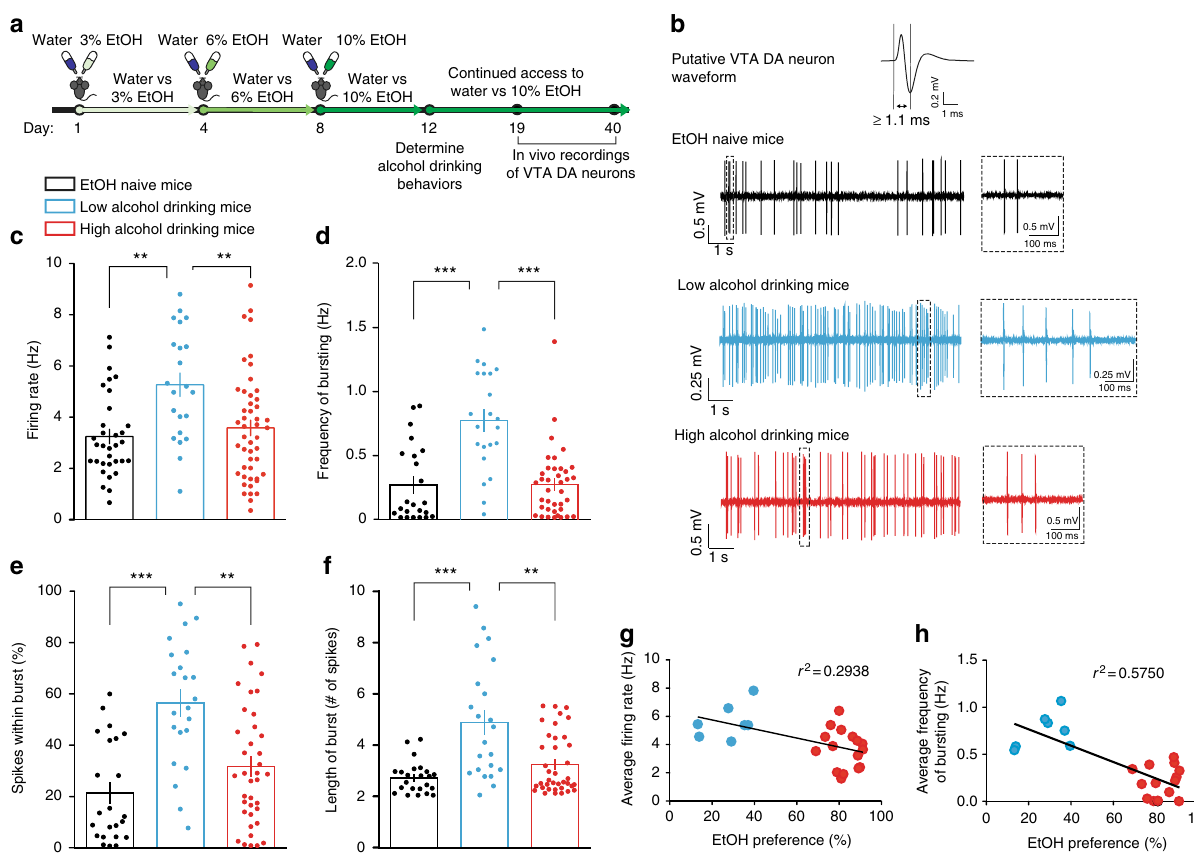
Fig. 2 Low alcohol drinking mice have higher VTA dopamine neuron activity in vivo. a Timeline for experiments and schematic of single-unit recordings. b Representative in vivo VTA dopamine (DA) neuron fi ring traces for EtOH naive, low alcohol drinking, and high alcohol drinking mice, where dashed boxes show representative bursts. c VTA DA neuron fi ring rate in vivo (Kruskal – Wallis: K (3) = 12.74, P < 0.01; post hoc Dunn ’ s multiple comparison test, ** P < 0.01. n = 33 cells from 7 mice; n = 22 cells from 7 mice; n = 48 cells from 16 mice). d VTA DA neuron frequency of in vivo bursting (Kruskal – Wallis: K (3) = 23.88, P < 0.0001; post hoc Dunn ’ s multiple comparison test, *** P < 0.001. n = 23 cells from 7 mice; n = 22 cells from 7 mice; n = 38 cells from 15 mice). e VTA DA neuron percentage of spikes within a burst in vivo (Kruskal – Wallis: K = 21.02, P < 0.0001; post hoc Dunn ’ s multiple (3) comparison test, ** P < 0.01, *** P < 0.001. n = 23 cells from 7 mice; n = 22 cells from 7 mice; n = 38 cells from 15 mice). f Average length of burst in VTA DA neurons in vivo (Kruskal – Wallis: K (3) = 16.34, P < 0.001; post hoc Dunn ’ s multiple comparison test, *** P < 0.001, ** P < 0.01. n = 23 cells from 7 mice; n = 22 cells from 7 mice; n = 38 cells from 15 mice). g Correlation between average VTA DA neuron in vivo fi ring rate and EtOH preference from individual alcohol drinking mice ( r 2 = 0.2938, P < 0.01. n = 23 mice). h Correlation between average VTA DA neuron in vivo frequency of bursting and